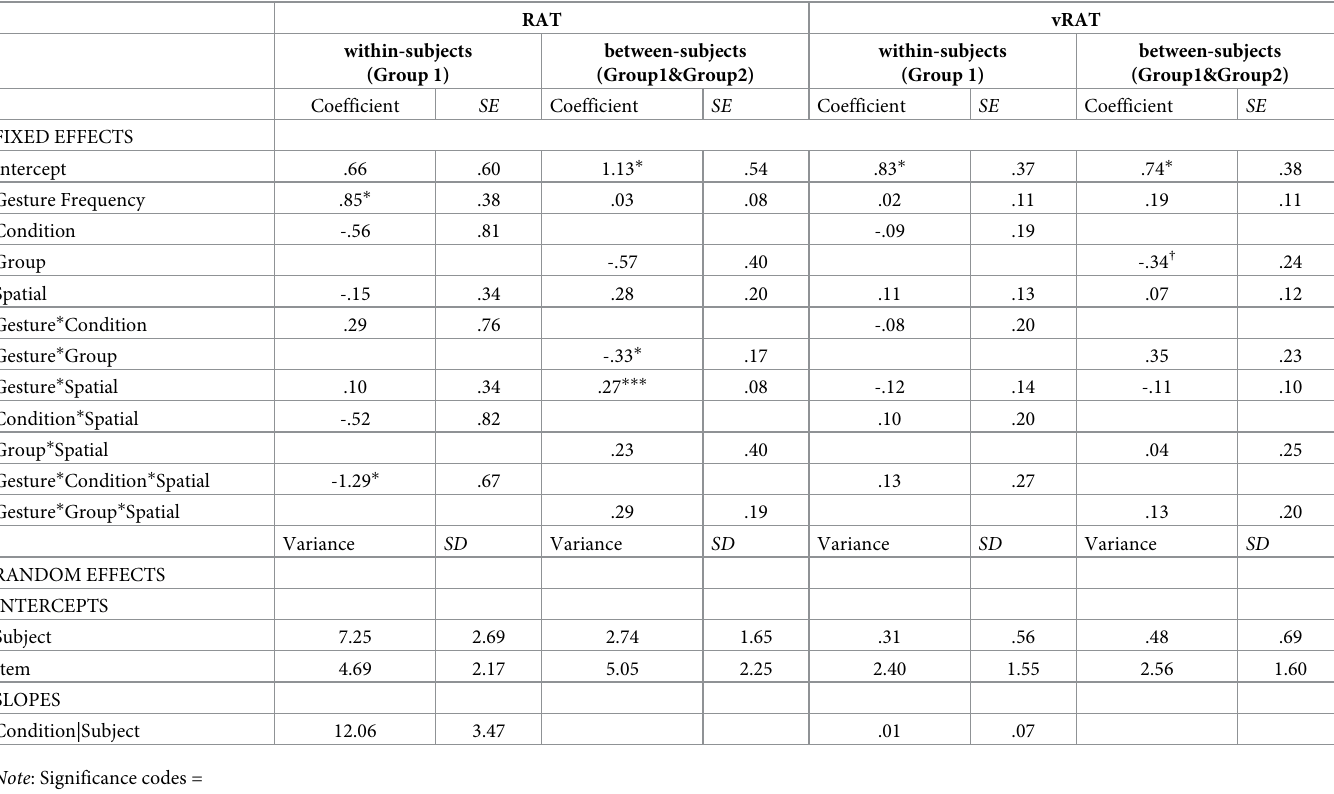
Table 8. Model summary for spatial